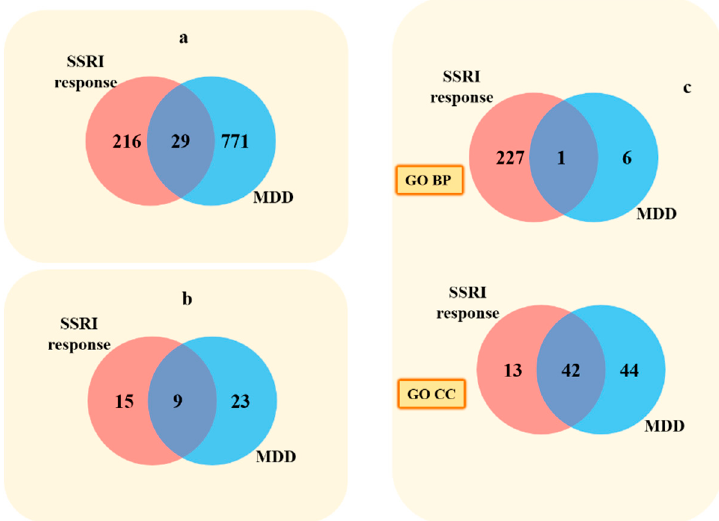
Figure 2. Common Genes ( a ), KEGG biological pathways ( b ), and GO terms ( c ) among SSRI response and MDD.